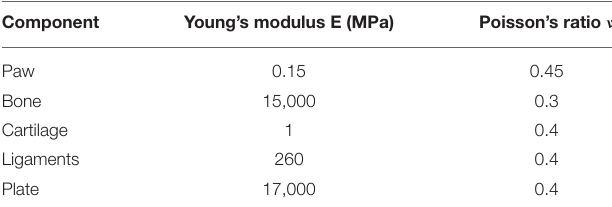
TABLE 1 | Material properties of the cat’s right forelimbs model